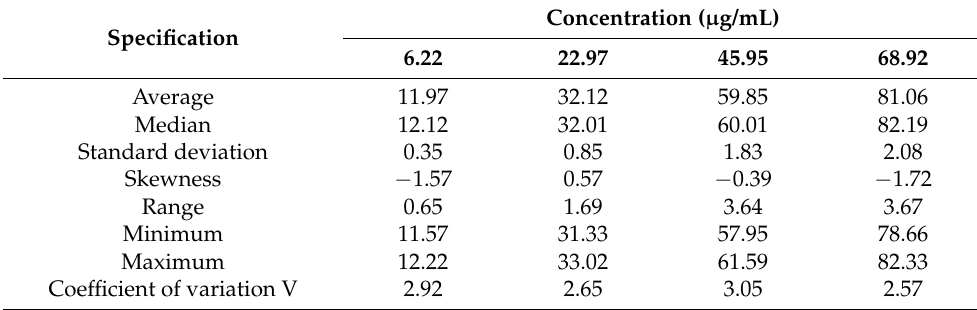
Table 12. ABTS radical scavenging activity of standard solution of vitamin E.